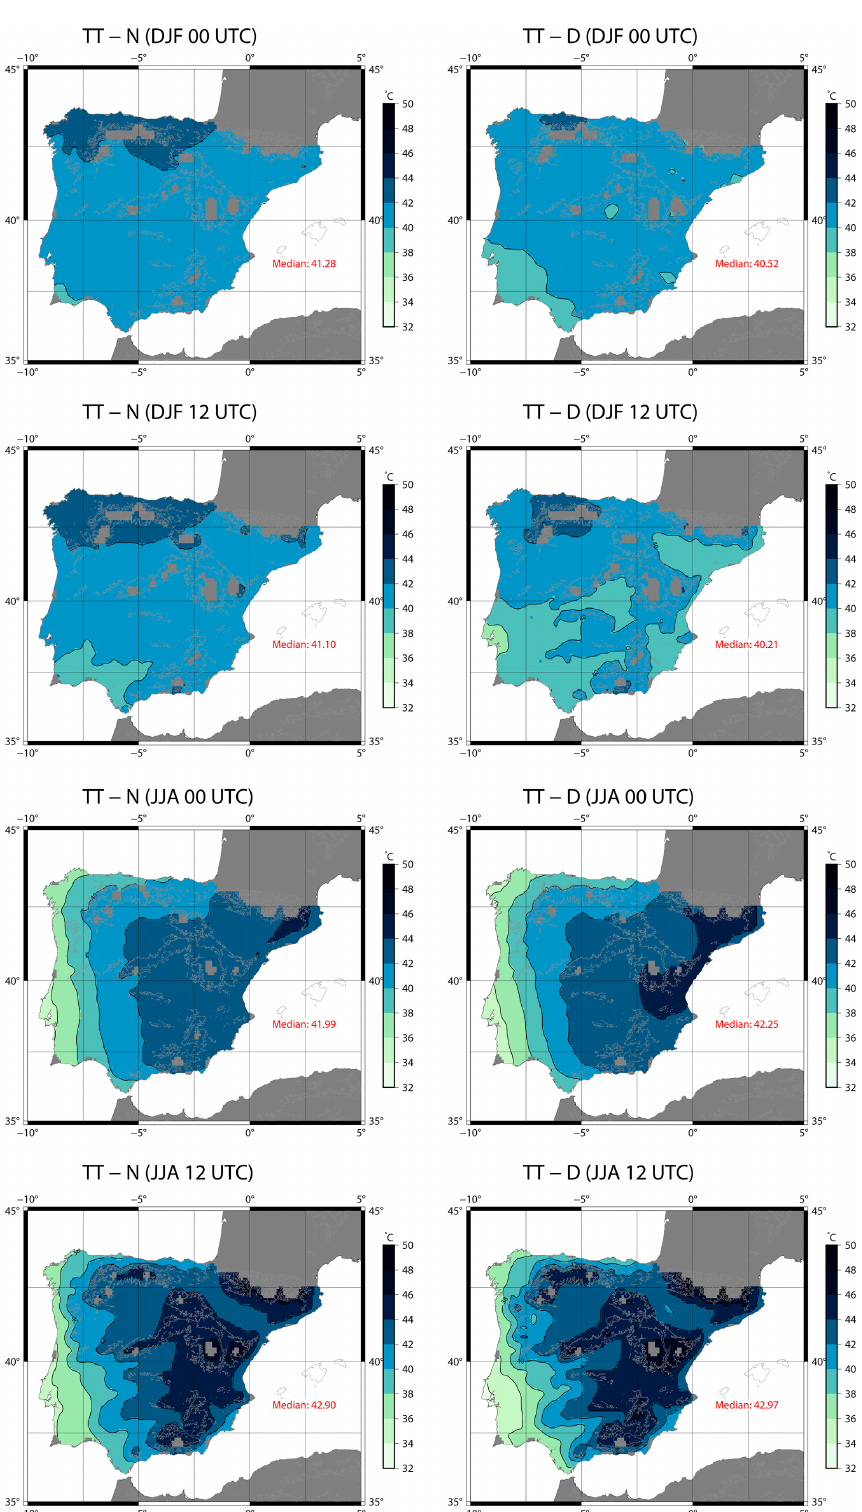
Figure 8. Spatial distribution of mean TT for the period 2010–2014 over the IP as computed from N (first column) and D (second column) for winter (rows 1 and 2) and summer (rows 3 and 4) at 00:00 (rows 1 and 3) and 12:00UTC (rows 2 and 4). The median value ( ◦ C) of each map is presented in the bottom right corner of the